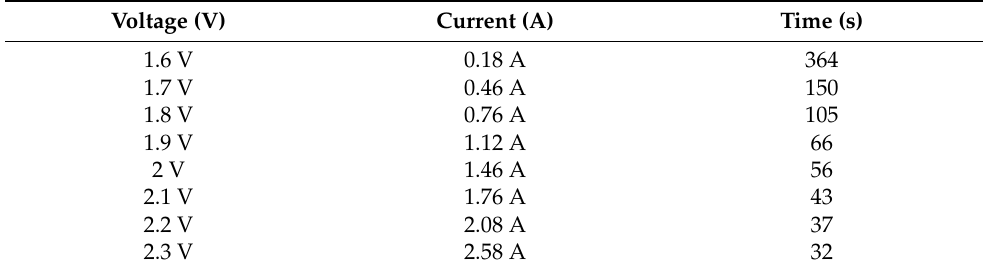
Figure 18. Mounting of the hydrogen cell (transparent) and a fuel cell (blue). Table 4. Characterization of an electrolytic cell in terms of voltage and